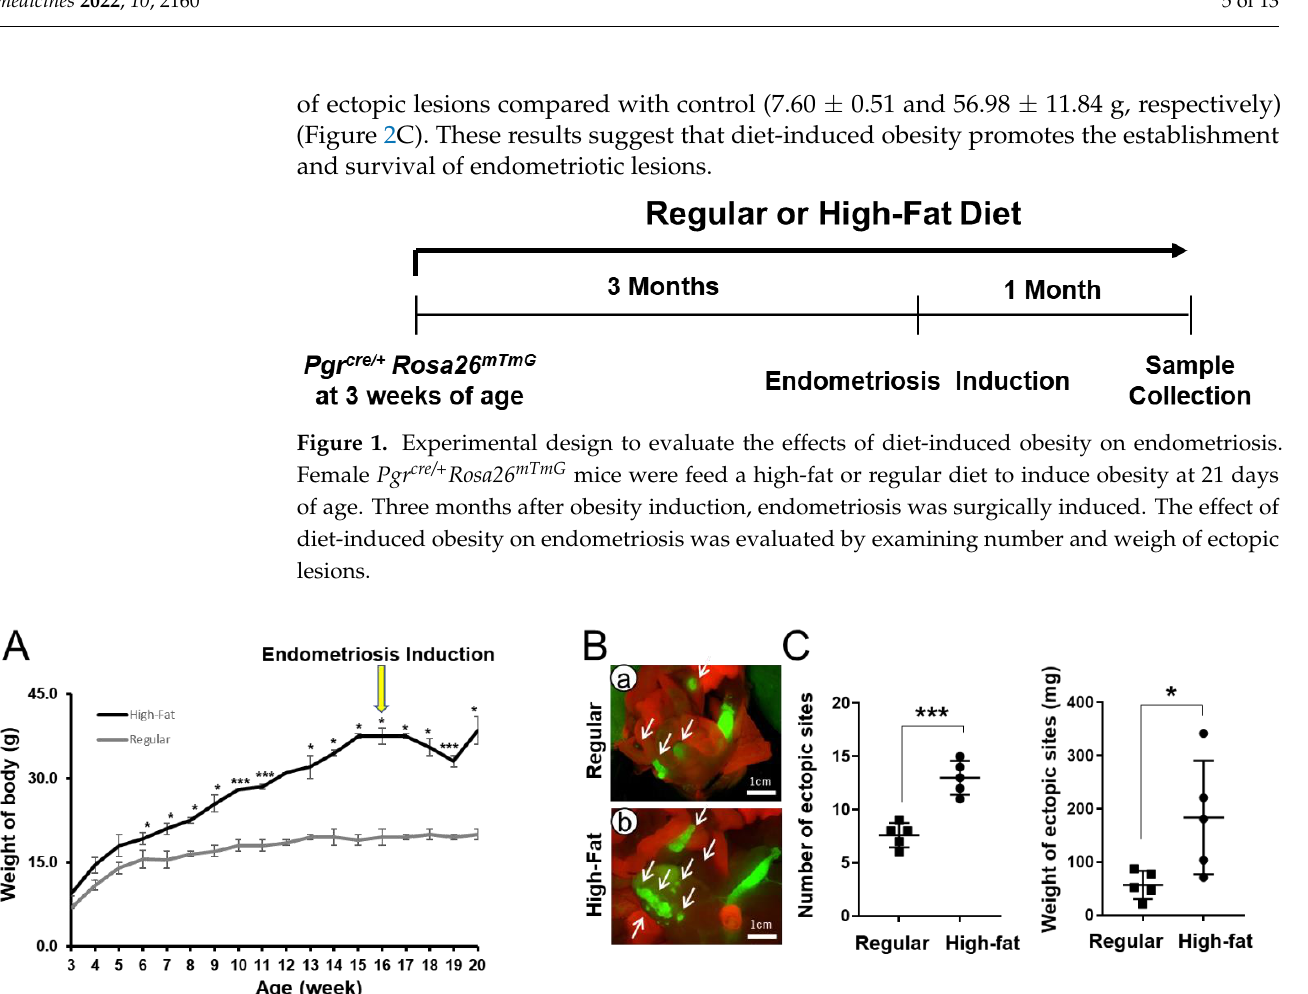
Figure 2. Effects of diet-induced obesity on endometriosis. ( A ) Changes in body weight in female Pgr cre/+ Rosa26 mTmG mice during the high-fat and regular diets. Female Pgr ere/+ Rosa26 mTmG mice were fed a regular or high-fat diet at 3 weeks of age. Body weight was measured once a week. Yellow arrow indicates the time of endometriosis induction. ( B ) Representative images of GFP-positive endometriotic lesions in high-fat ( b ) and regular ( a ) diet groups. Endometriosis was surgically induced in the regular and high-fat dieted mice. Endometriotic lesions were visualized under stereo microscope with fluorescence. ( C ) The quantification of number and weight of ectopic lesions were significantly increased in high-fat diet mice compared with regular diet mice. Data are represented as mean ± SEM. * p < 0.05 and *** p < 0.001.